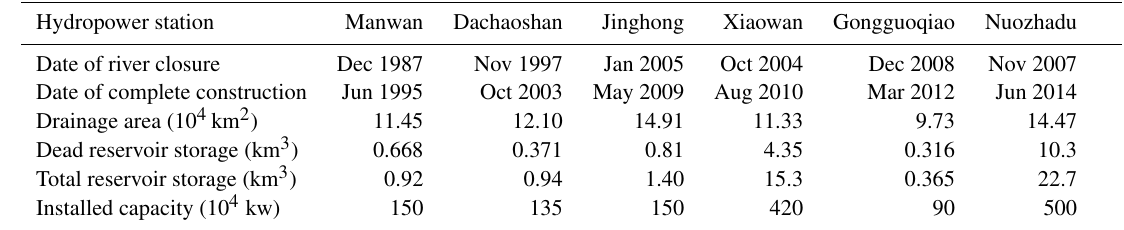
Table 1. Basic information for the six large constructed dams on the mainstream of the LR basin. Hydropower station